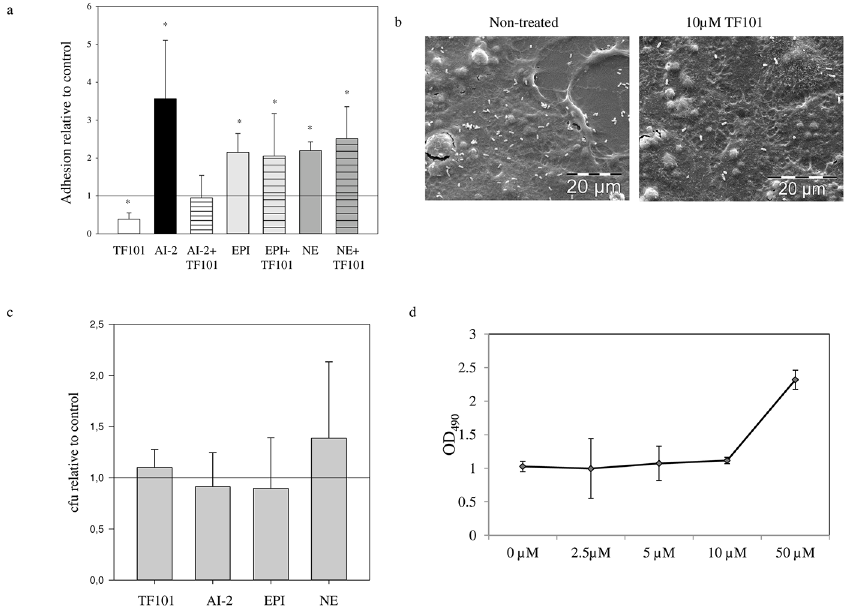
Fig 4. Adhesion of E . coli O103:H2 to Caco-2 cells. (a) Mean ± SD number of bacteria (n = 12) attached to Caco-2 cells, relative to control (= 1 reference line). 10 μ M TF101, 10 μ M AI-2, 10 μ M AI-2 + 10 μ M TF101, 50 μ M epinephrine (EPI), 50 μ M epinephrine + 10 μ M TF101, 50 μ M norepinephrine (NE), or 50 μ M norepinephrine + 10 μ M TF101 was added during the adhesion assay. * Significantly different from control, P < 0.05. (b) SEM images of adherent E . coli O103:H2 on Caco-2 cells with or without addition of 10 μ M TF101. Scalebar, 20 μ m. (c) Adhesion of E . coli O103:H2 to Caco-2 cells pre-exposed and non-pre-exposed to TF101. The cells were exposed to 10 μ M TF101 before the bacteria were added in order to test any possible effect of TF101 on the cells. The effect of pre-exposure of TF101 is presented relative to non-pre- exposed cells (indicated by the reference line = 1). The data are presented as mean values ± SD (n = 12). (d) Cytotoxic effect of TF101 on Caco-2 cells. Release of lactate from Caco-2 cells exposed to 0 μ M, 2.5 μ M, 5 μ M, 10 μ M and 50 μ M T101. The data are presented as mean values ± SD (n = 6).